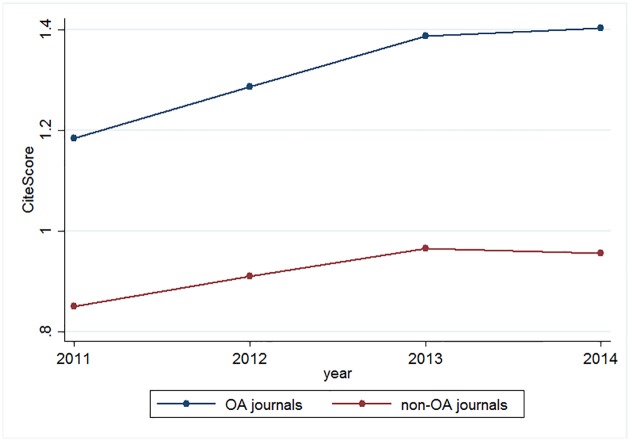
CiteScores by year.